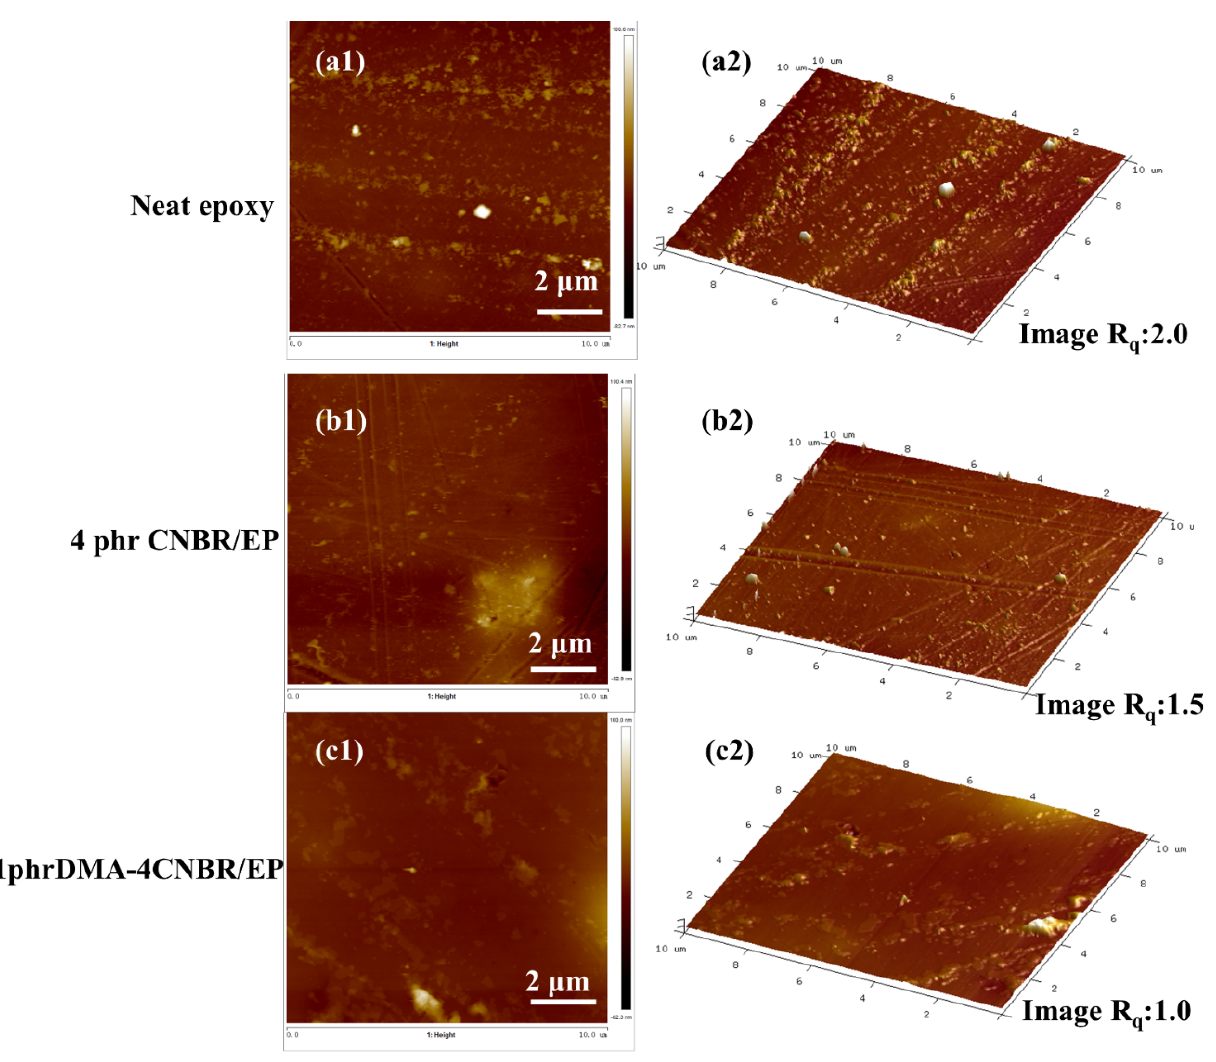
Figure 5. AFM micrographs of the coatings: ( a1 – c1 ) the 2D topographical characteristics of AFM; ( a2 – c2 ) the 3D topographical characteristics of AFM.